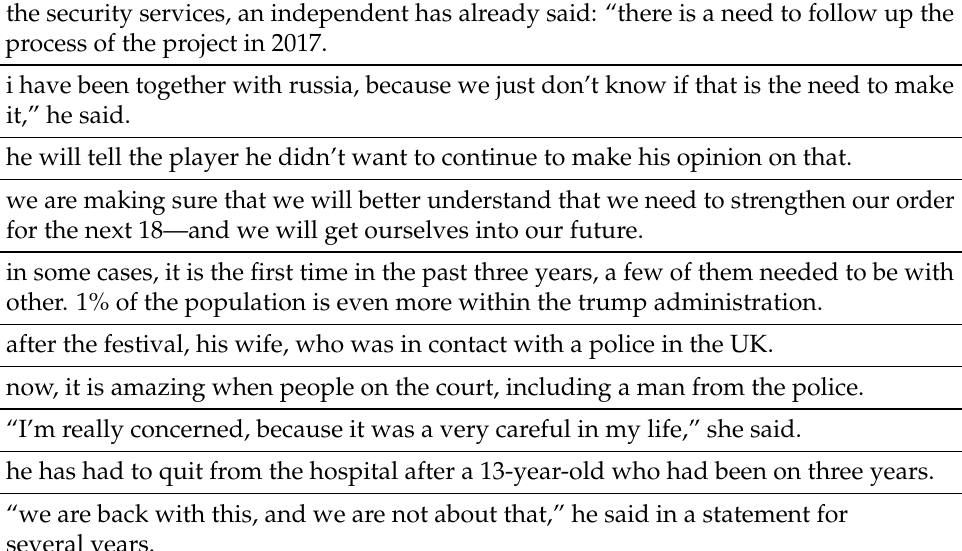
Table A2. The data samples generated from the EMNLP 2017 WMT News